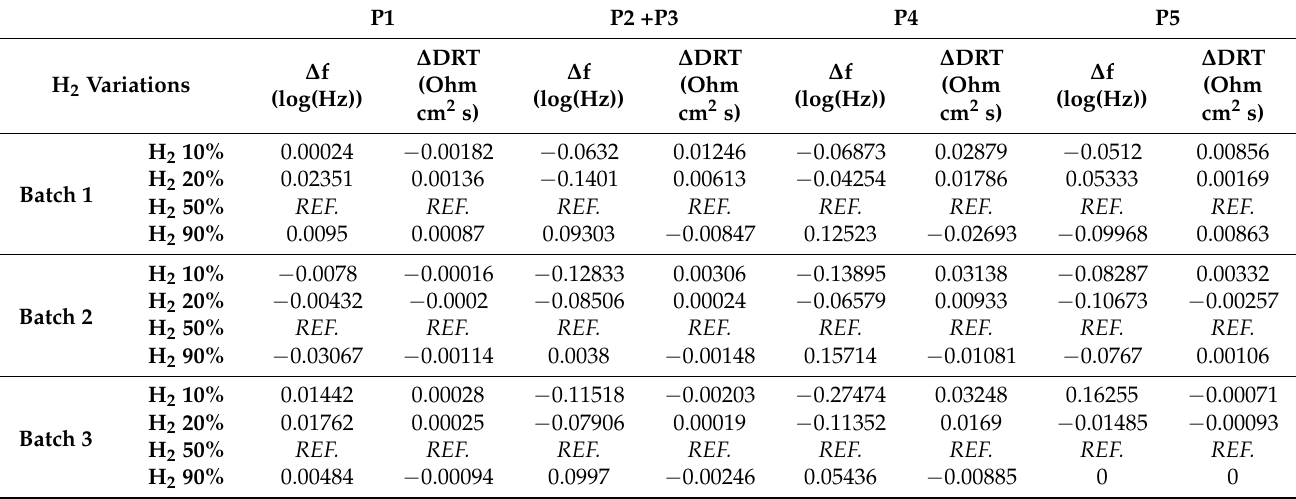
Table 4. Frequency and DRT amplitude change due to hydrogen variation at 700 ◦ C and O 2 21%. REF. stands for the reference value. P1 P2 +P3 P4 P5